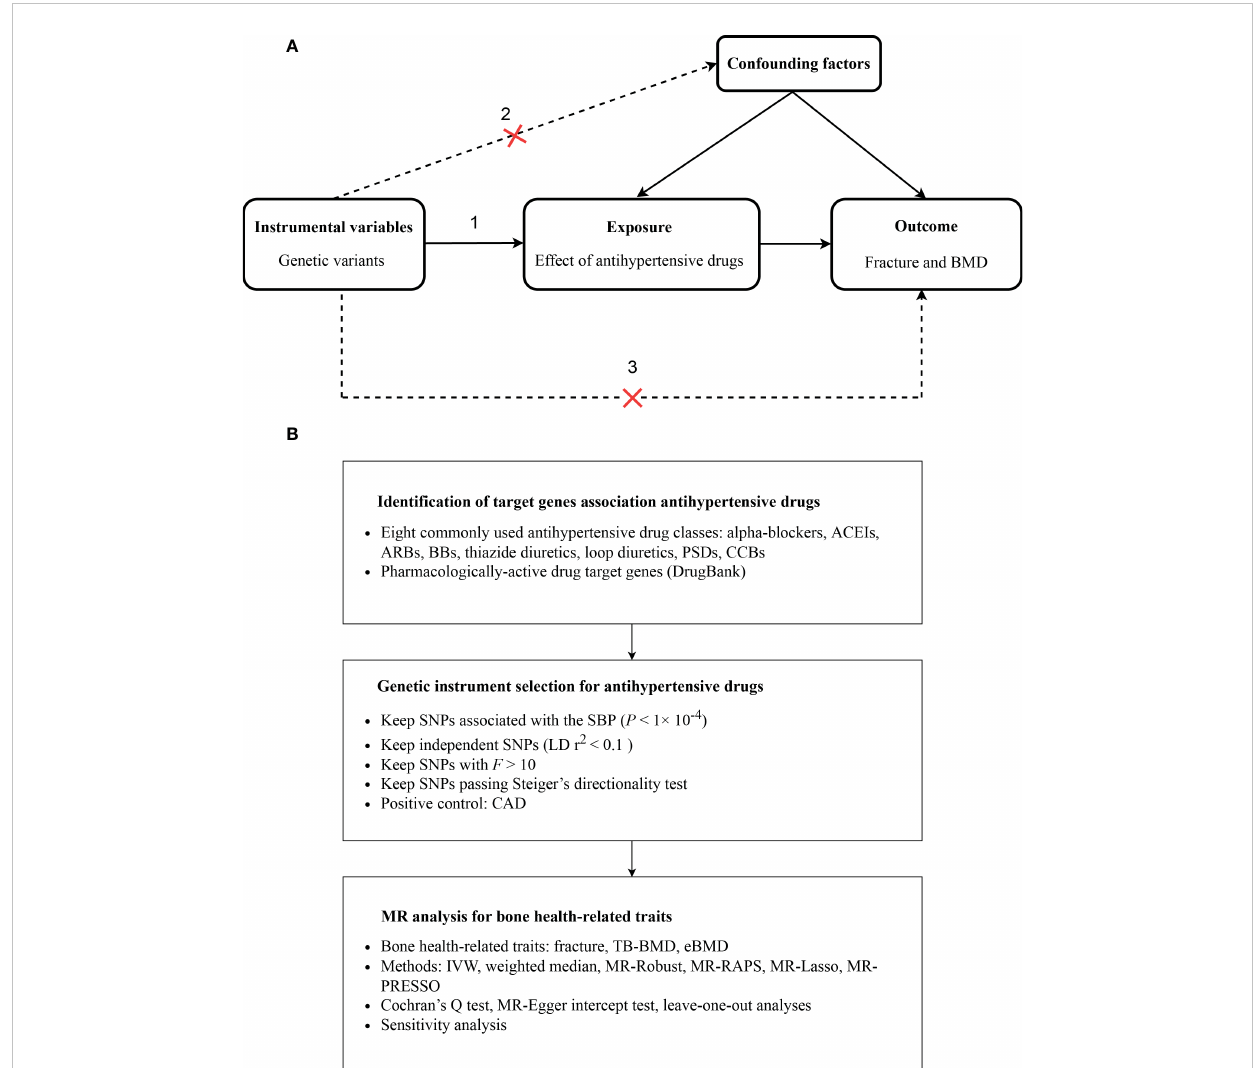
FIGURE 1 Diagram of the study design. (A) The drug-target MR framework in this study. Three assumptions are often required: (1) the selected instrument is predictive of the exposure, (2) the instrument is independent of confounding factors, and (3) there is no horizontal pleiotropy (the instrument is associated with the outcome only through the exposure). (B) The overall study design. IVW, inverse-variance weighted; MR, Mendelian randomization; MR-RAPS, Robust Adjusted Pro fi le Score; MR-PRESSO, Mendelian randomization Pleiotropy RESidual Sum and Outlier; CAD,